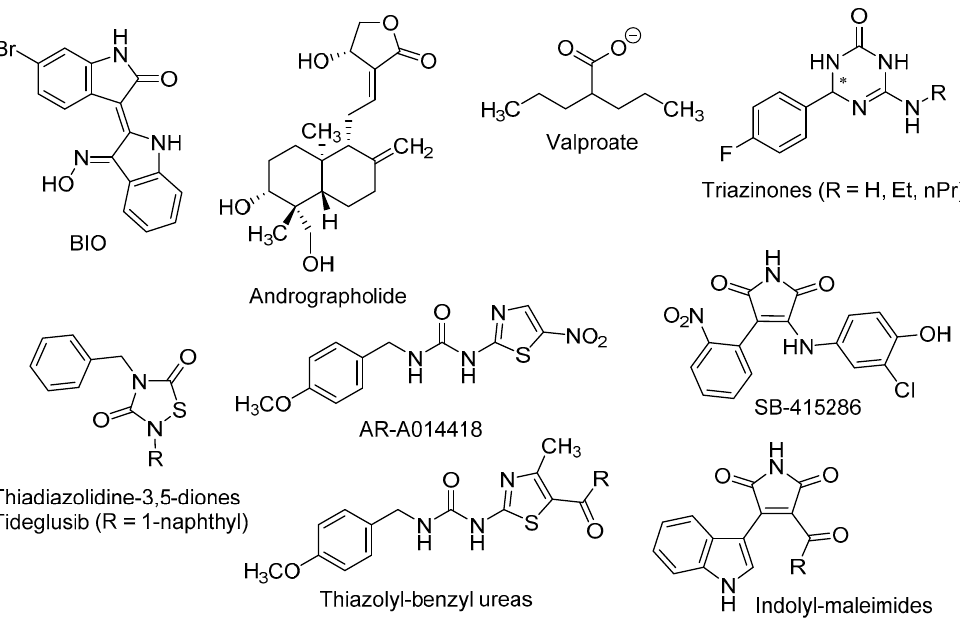
Figure 3. Neurogenic molecules acting at the Wnt/ β -catenin pathway.